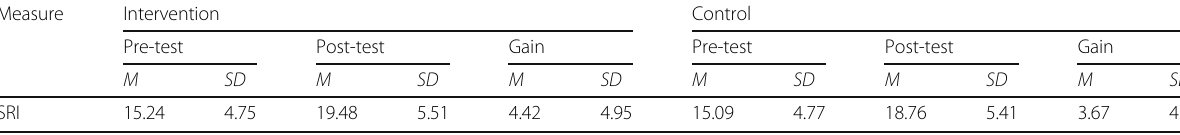
Table 3 Pre-tests, post-tests, and pre-test – post-test gains for SRI by condition